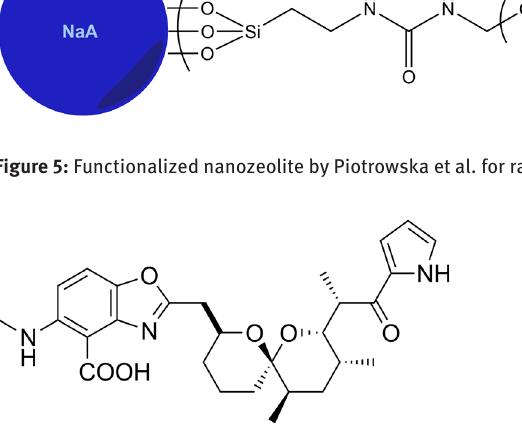
Figure 6: Ca-ionophore A23187 utilized to transport radium into